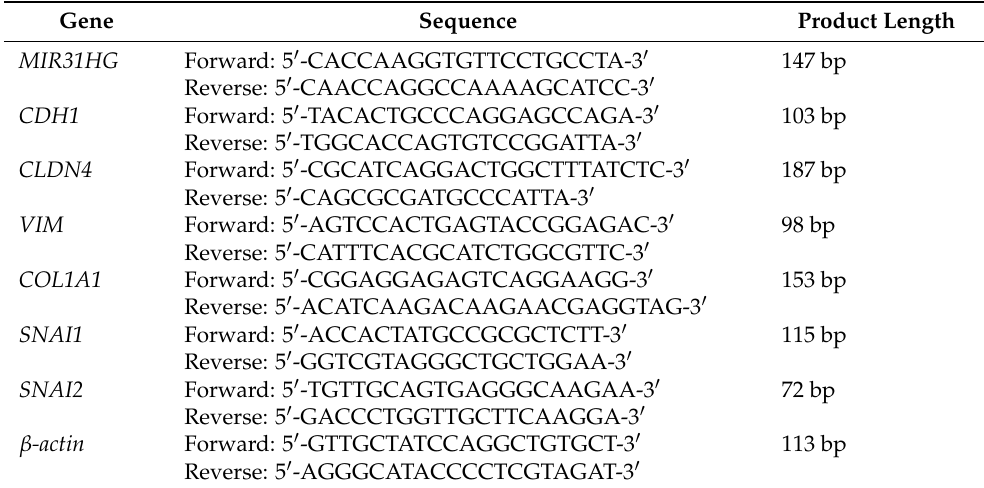
Table 1. Primer pairs used in this